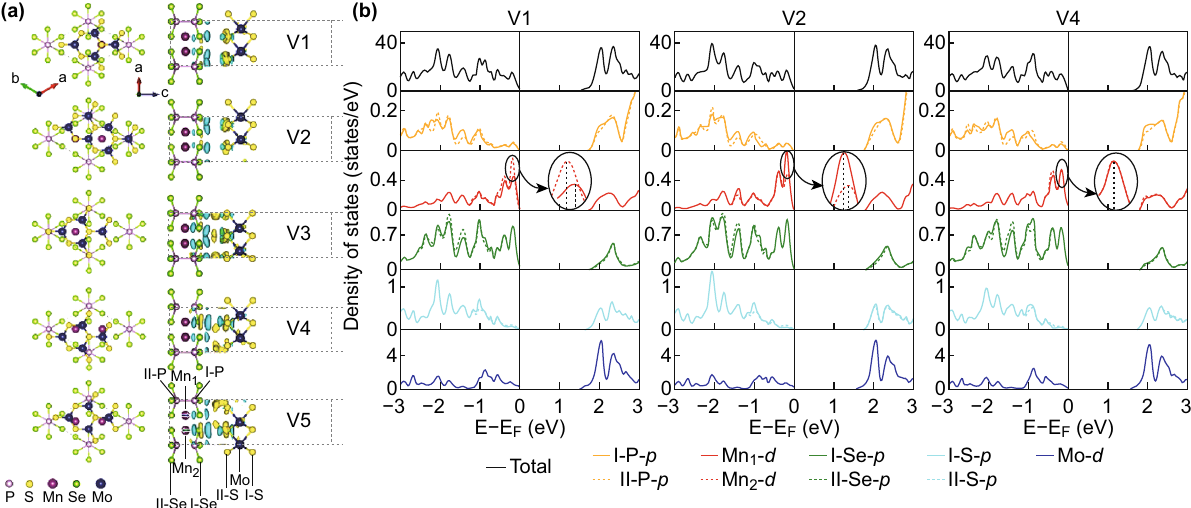
Fig. 3 a Structure and side view of the charge density difference of MnPSe 3 /MoS 2 heterostructures with different stacking models V1–V5. The isosurface value is 0.15 e nm - 3 . Yellow (blue) regions represent the net charge gain (loss). b Total and partial DOS of V1, V2, and V4 configurations. Fermi level is indicated by the vertical shadow line and set to zero [56]. Reproduced with permission. Copyright (2017), Macmillan Publishers Ltd. (Color figure